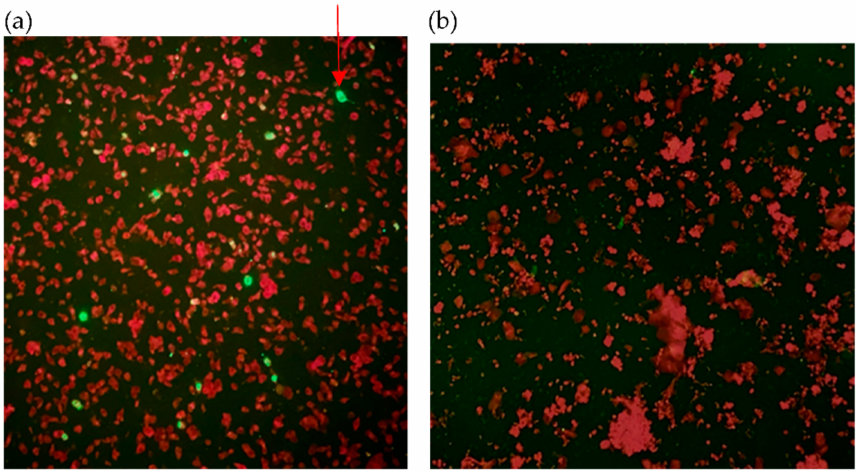
Figure 1. Smears of cells stained with primary antibody against SARS-CoV N protein (original mag- nification × 200). ( a ) Smear of cells from COVID-19 patients with positive results. ( b ) Smear of cells from non-infected individuals with negative results. Red arrow indicates positive cell.